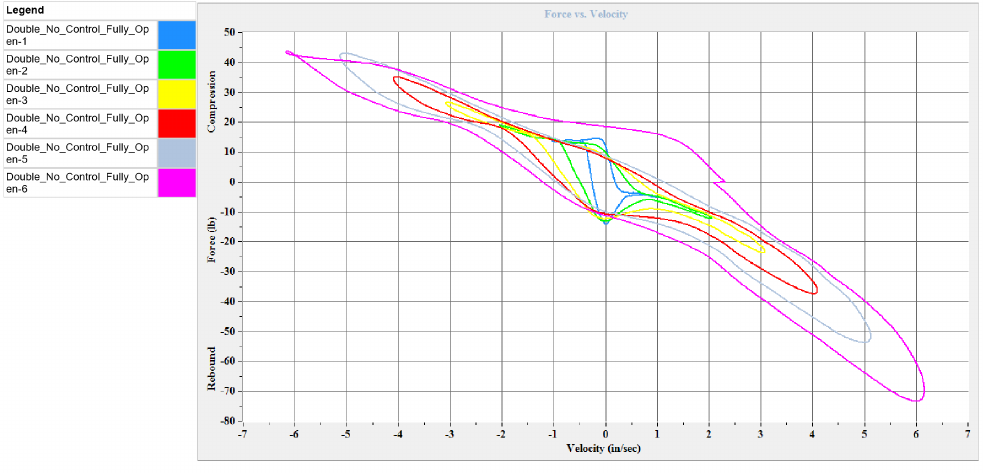
Figure 9. Force vs Velocity Plot for Passive Double Damper with Fully Open Valve (No